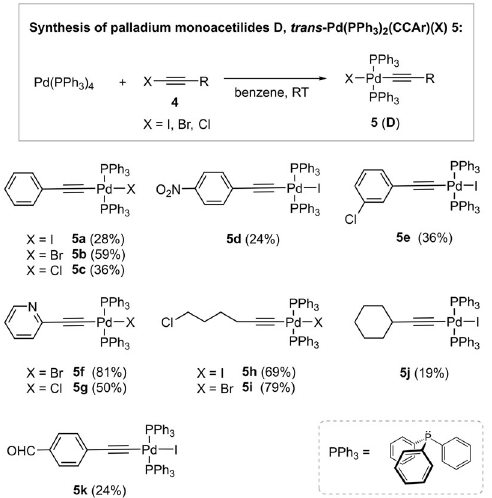
Fig. 3 Preparation of palladium monoacetylides trans -Pd(PPh 3 ) 2 (CCAr) (X) (5) that mimic intermediate D. Synthetic details are described in Supplementary